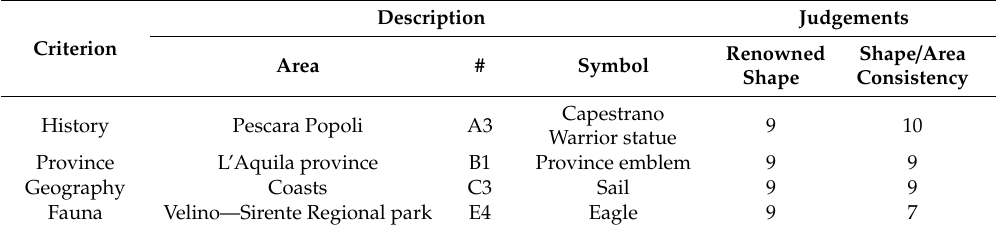
Table 8. Final criteria for the subdivision in areas (subdivision by items of